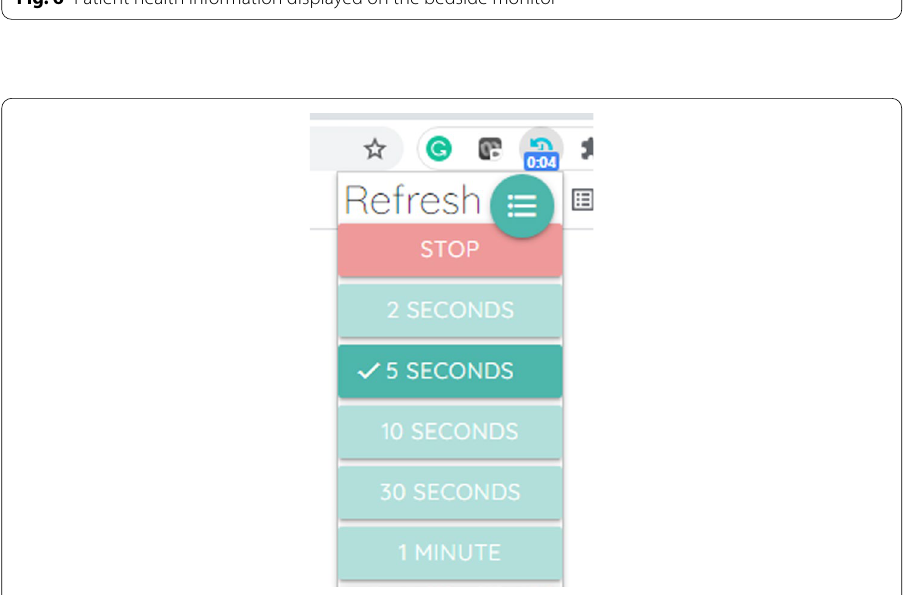
Fig. 7 Google chrome auto-refresh